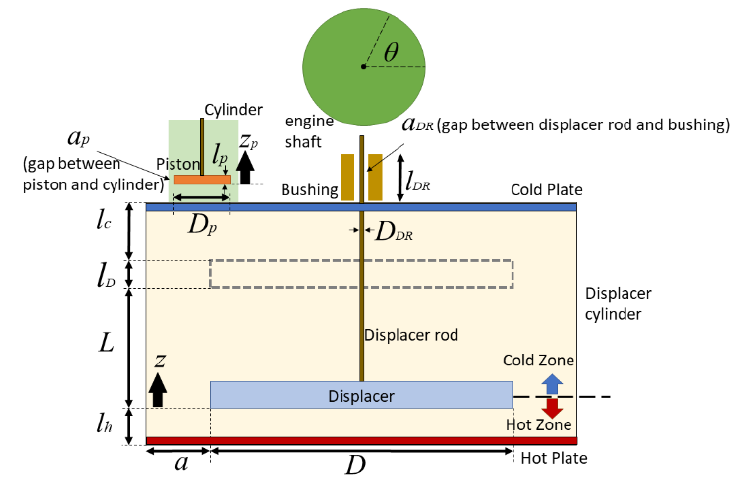
Figure 2. Nomenclature and major components of the gamma-type Stirling engine.